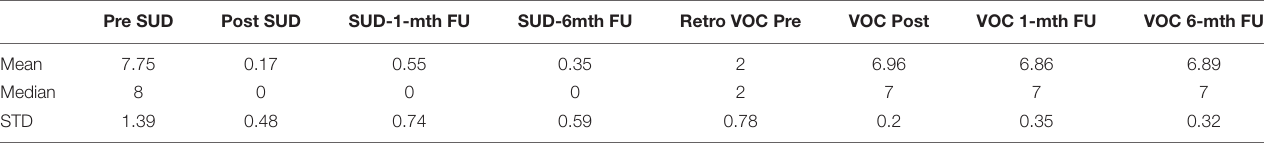
TABLE 3 | Descriptives – subjective unit of disturbance (SUD) and validity of cognition (VOC): pre, post, 1-month, and 6-month FUs ( N = 24).